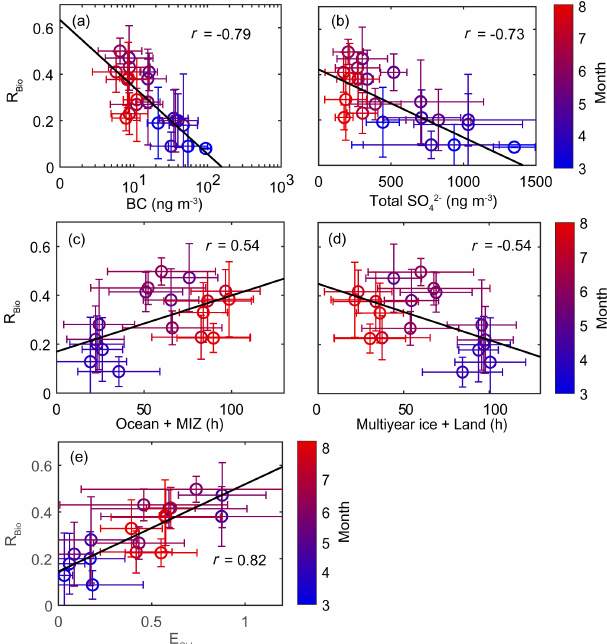
Figure 9. Scatter plots of monthly mean R Bio values as a function of (a) the monthly mean black carbon (BC) concentration, (b) the monthly mean total SO 2 − concentration, (c) the air mass retention 4 time over the ocean and the marginal ice zone (MIZ), (d) the air mass retention time over multi-year ice and land areas, and (e) the monthly mean air mass exposure to chlorophyll ( E Chl ). Error bars Figure 8. Plots of the seasonal (a) black carbon (BC) concentra- and the black solid line represent 1 σ and the best fit, tion versus R Bio , (b) the total SO 2 − concentration versus R Bio , and 4 (c) the number of samples included in each R Bio group. The solid and dotted lines represent the median and mean values of the data in the box plots, respectively.